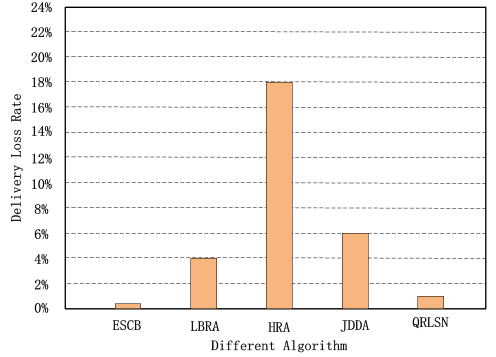
Figure 16. Delivery performance comparison.